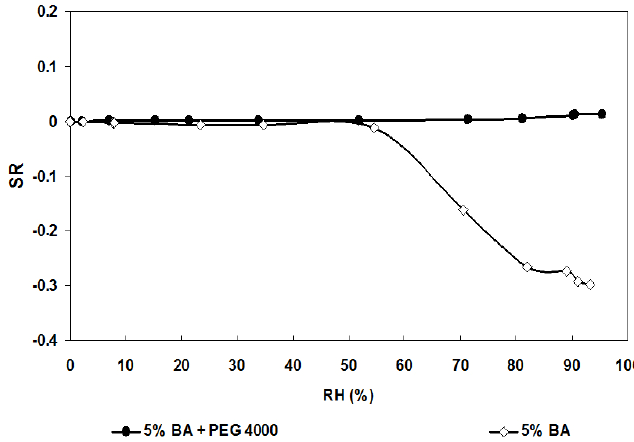
Figure 4. Humidity sensors (5% BA) response after 3 min of valve switch in function of RH, at 20 °C, for the samples fired at 1300 °C, with and without PEG 4000